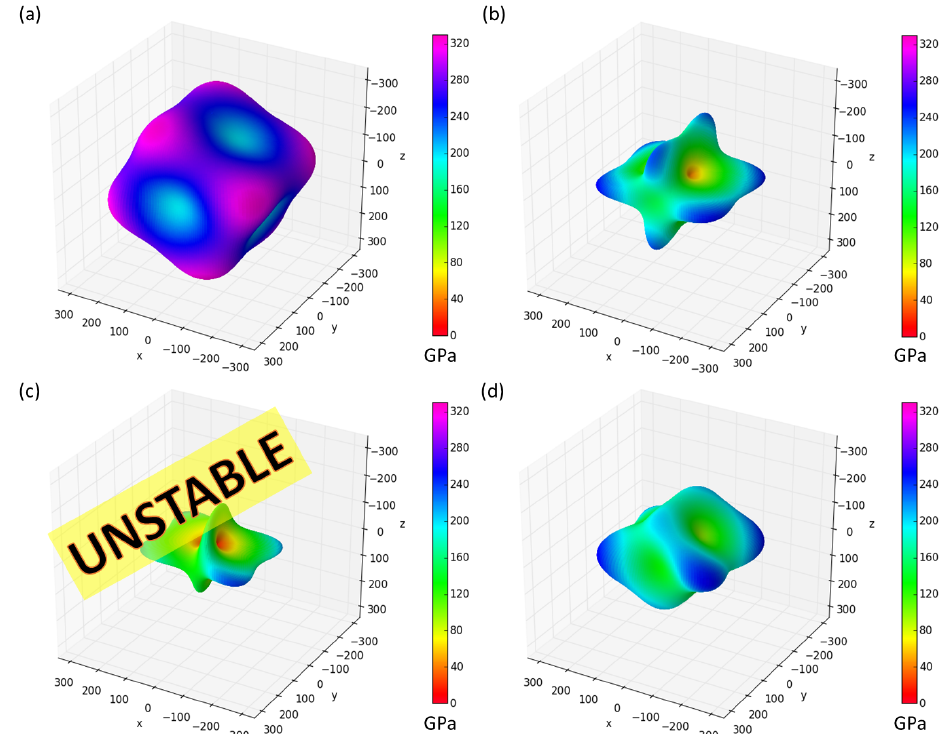
Figure 2. Visualization of directional dependences of the Young’s modulus of the studied Ni 3 Si systems, ( a ) the Ni 3 Si bulk in the coordination system of the studied GBs, ( b ) Σ 5(210) Ni,Ni , ( c ) mechanically unstable Σ 5(210) Si,Ni (rectangular-parallelepiped supercell) and ( d ) mechanically stable Σ 5(210) Si,Ni (sheared-parallelepiped supercell) when the GBs plane is the x-y plane. The directional dependences were visualized by the SC-EMA [80–82] library (scema.mpie.de) and derived from the elastic